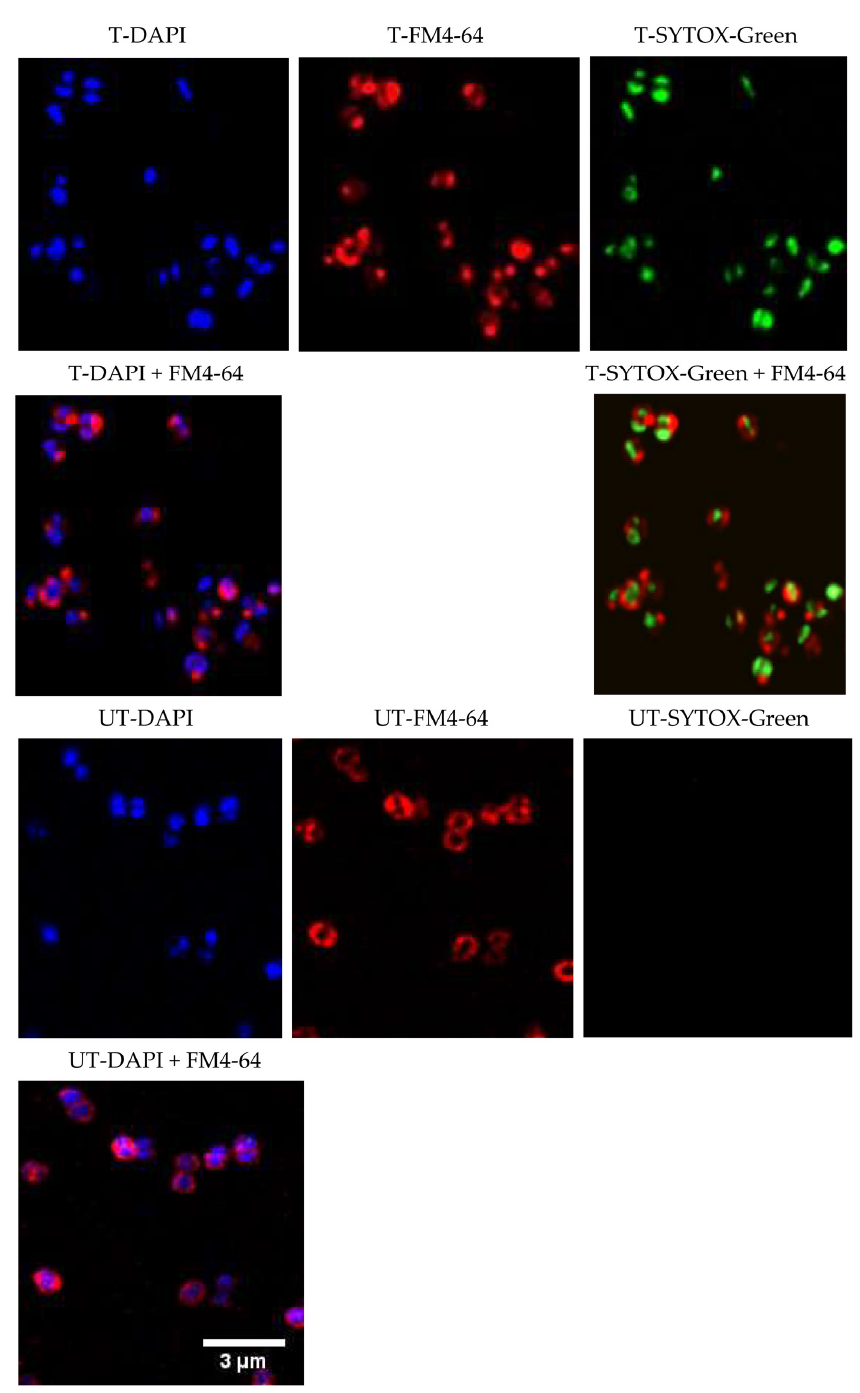
Figure 5 . Fluorescence microscopy of MRSA BH1-CC cells in the absence and presence of Spg-A. Exponential phase bacteria were treated with Spg-A for 1 h and then stained with FM4-64 (red), DAPI (blue), and SYTOX green (green). SYTOX green brightly stains cells with permeabilized membranes. Images of each fluorescent dye were acquired separately and overlaid in a single image. UT—Untreated; T—Treated. T-DAPI T-FM4-64 T-SYTOX-Green; T-DAPI + FM4-64 T-SYTOX-Green + FM4-64; UT-DAPI UT-FM4-64 UT-SYTOX-Green; UT-DAPI + FM4-64. Scale bar—3 µ m.